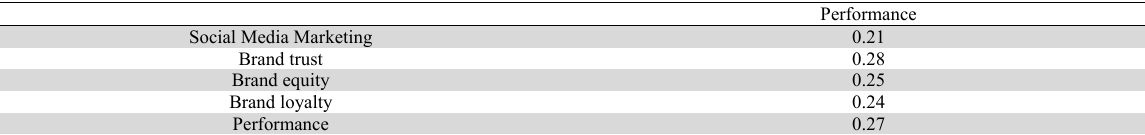
f 2 Effect Sizes Evaluation